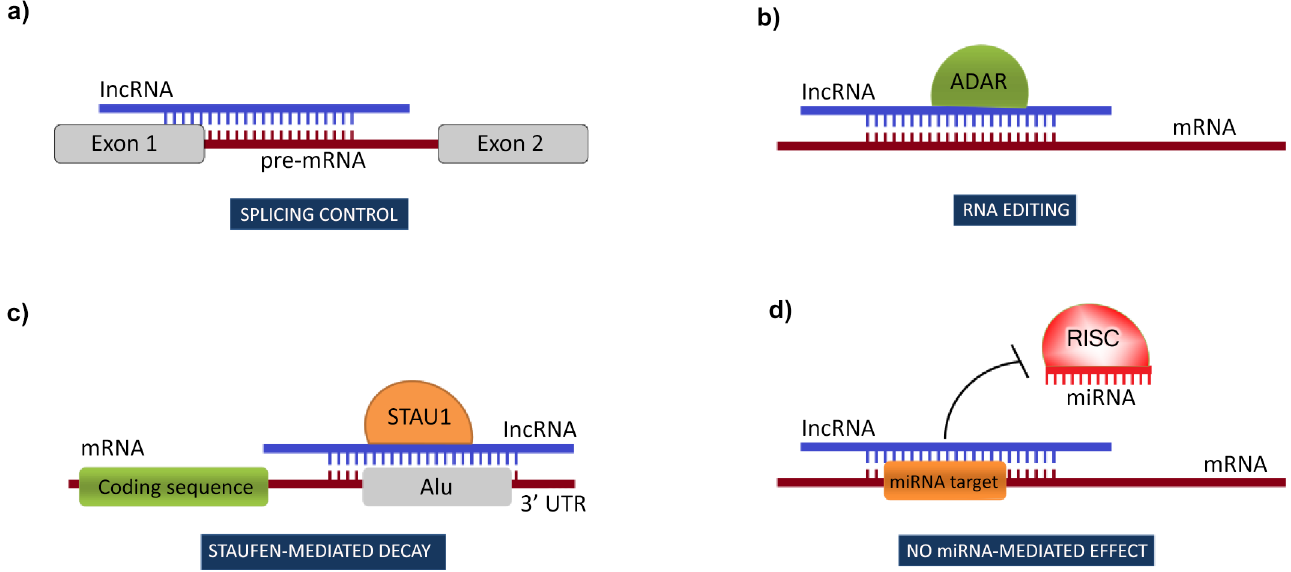
Fig 1. Possible roles of lncRNA-mediated interactions in transcript processing, stability control and expression regulation.